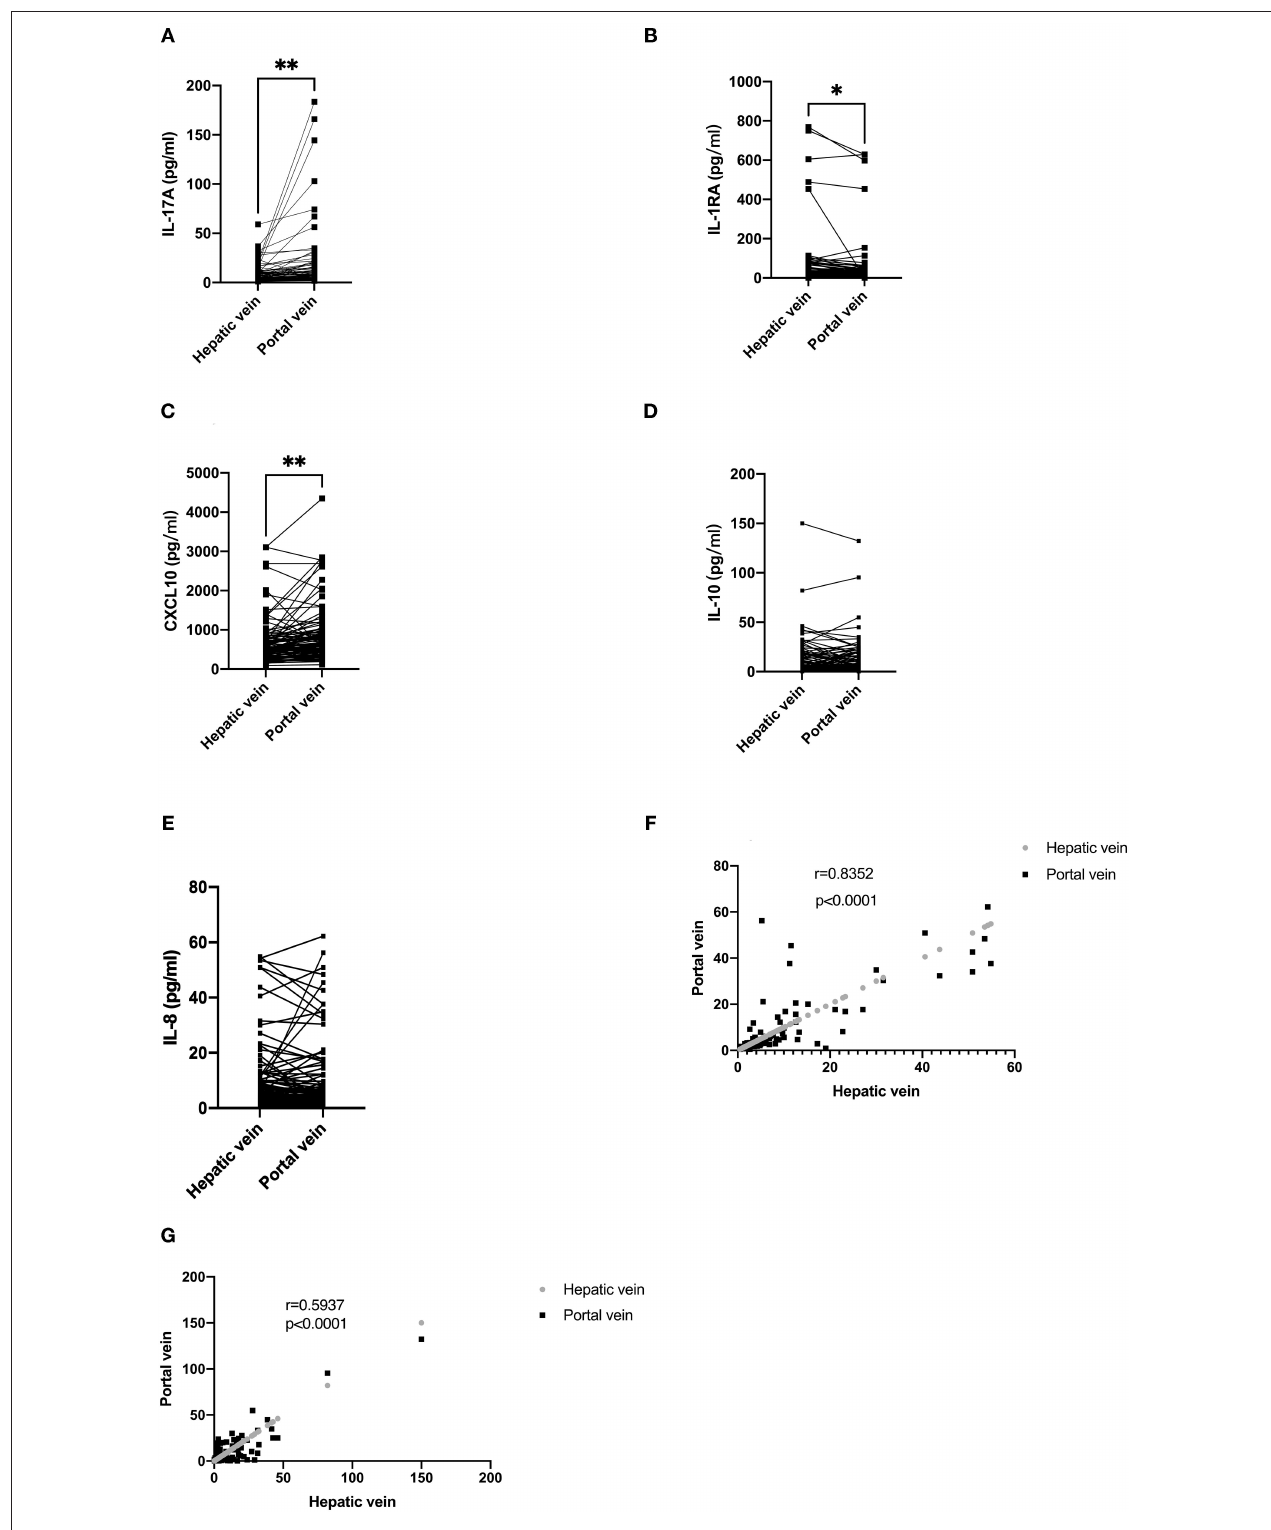
FIGURE 1 | Serum levels of cytokines in the portal and hepatic veins and correlation between portal and hepatic veins. (A) The level of IL-17A in the portal vein was higher than in the hepatic vein. (B) The level of IL-1RA in the hepatic vein was higher than in the portal vein. (C) The level of CXCL10 in the portal was higher than